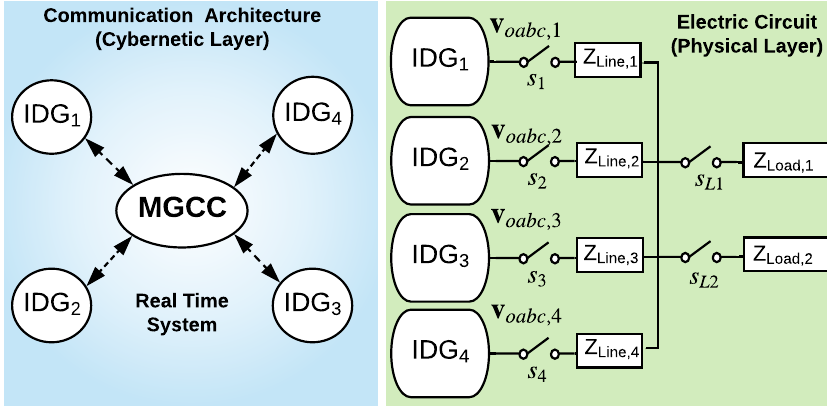
Figure 2. Cyber Physical Model of the